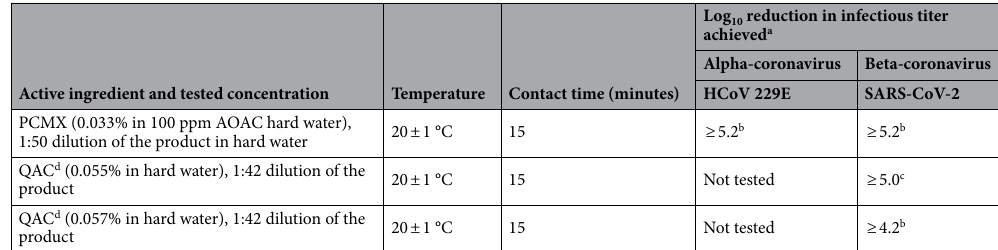
Table 2. Virucidal efficacy of laundry sanitizers tested per EN 14,476:2013 + A2:2019 on SARS-CoV-2 and HCoV 229E in suspension studies in the presence of an organic load. HCoV 229E human coronavirus